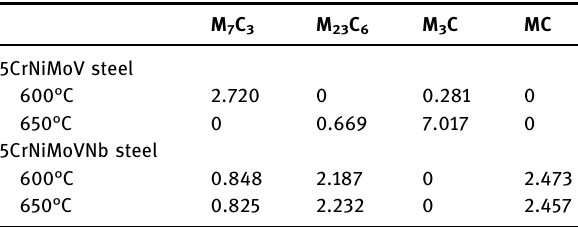
Table 5: Mass fraction of carbides in the two steels at di ff erent equilibrium temperatures ( %